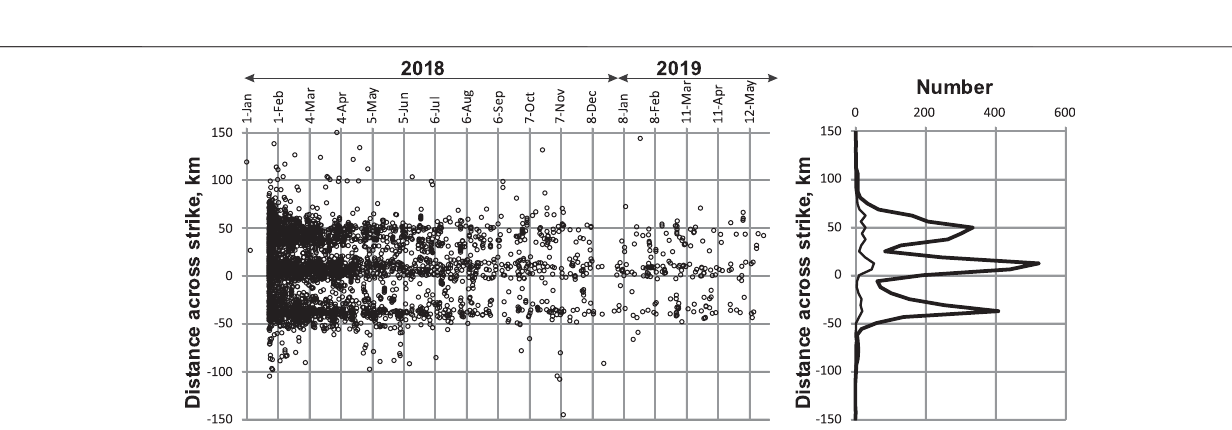
FIGURE 10 | Distribution of M ≥ 2.5 earthquakes across strike of the M W 7.9, January 23, 2018 main shock in time (left) and in number (right). The sub-meridian clusterdominatesbothinthe fi rstdayofaftershocks(thinline)andtotheendofMay2019(heavyline);itswidthismuchsmallerthanitslengthalongthemainshockstrike ( ψ (cid:1) 165 °